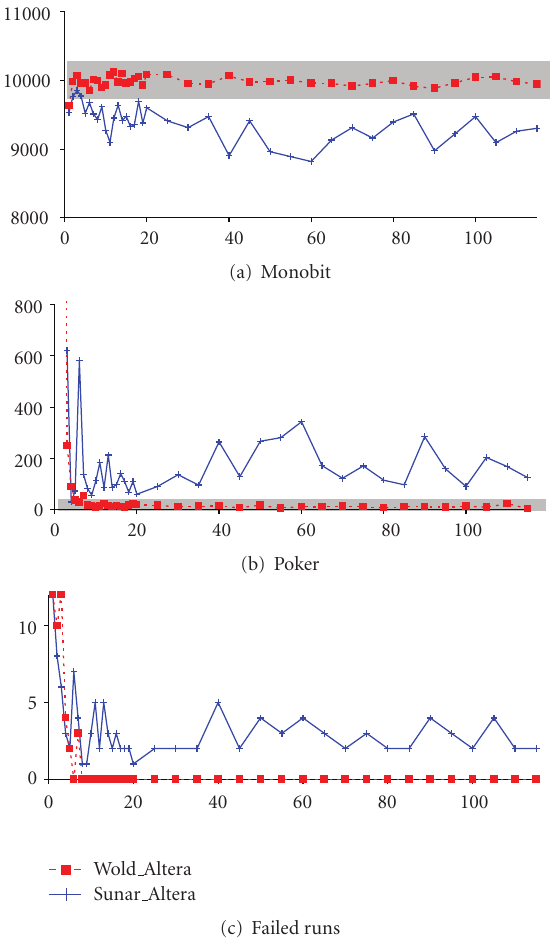
Figure 6: Results of the FIPS 140-2 tests for observed TRNG architectures with varying number of ring oscillators in Altera Cyclone III device.